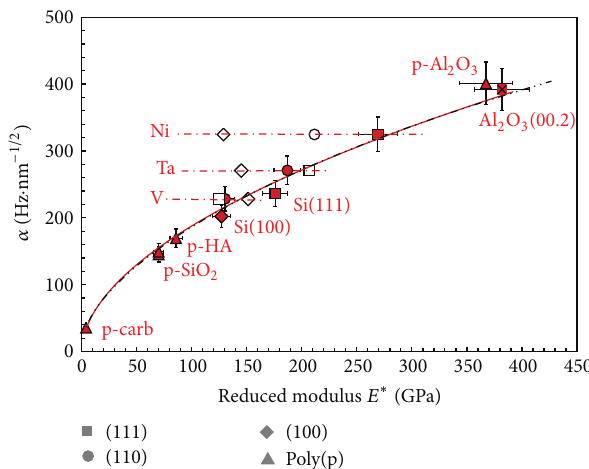
Figure 5: The measured 𝛼 value ( 𝑠 )that corresponds with the square root of the slope in region 3 󸀠󸀠 (of Figure 1) is plotted as function of the reduced modulus 𝐸 ∗ value for various sample materials where the crystalline orientation is indicated by the symbol shape in the